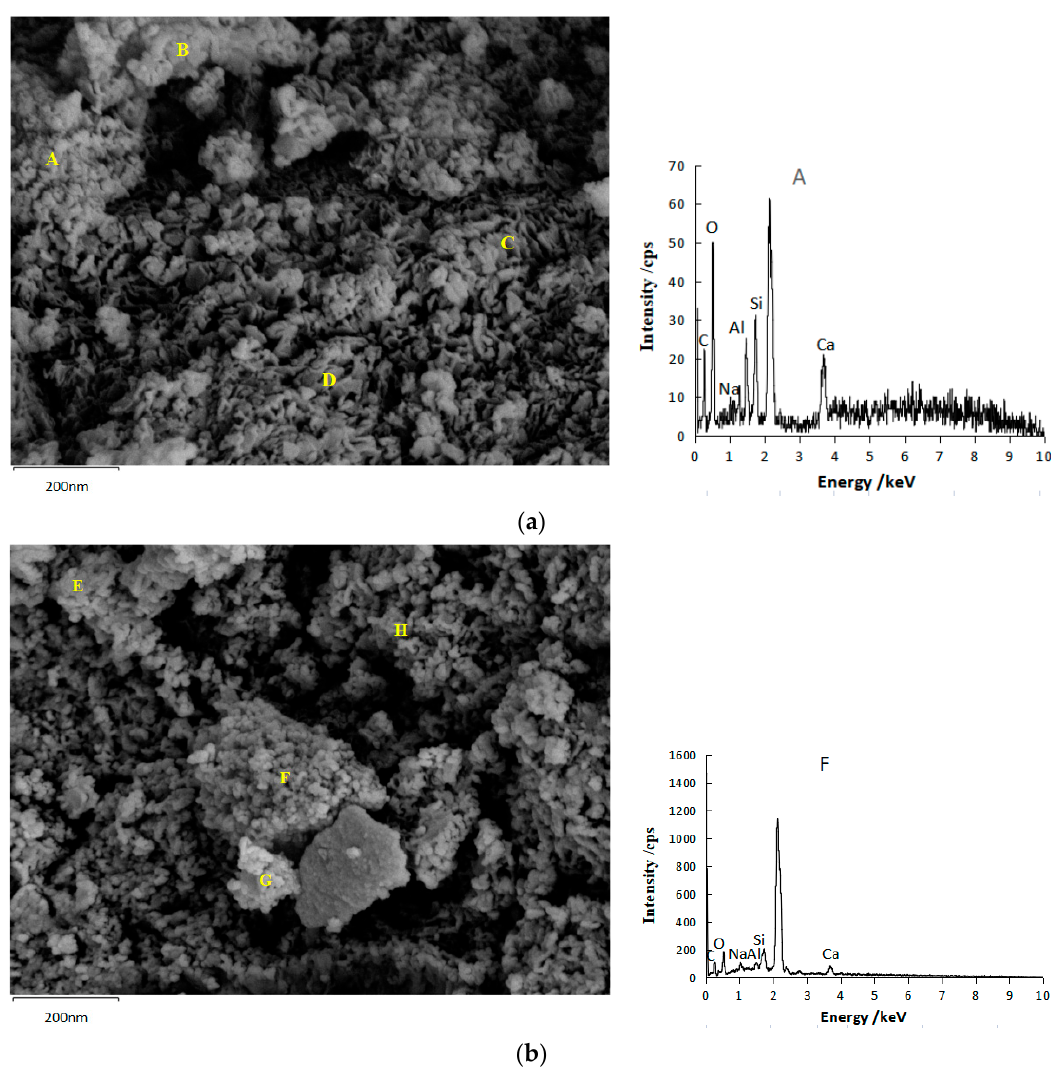
Figure 14. SEM and EDS of geopolymer. ( a ) SH18 geopolymer and A point EDS ( b ) SSG13 geopolymer and F point EDS. Table 1. Atomic percentage at each point in the EDS test/ %.